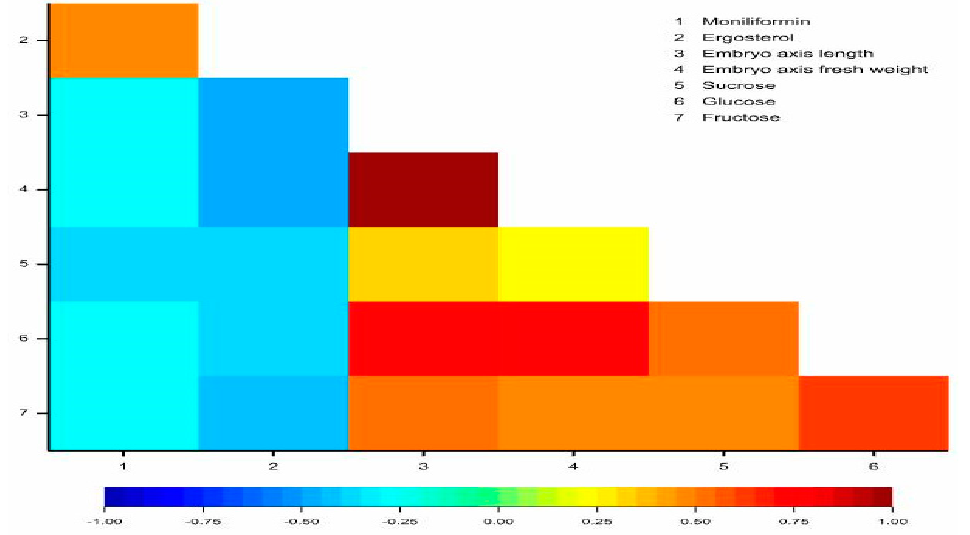
Figure 6. Heatmap matrix for linear Pearson’s correlation coefficients between moniliformin, ergosterol, embryo axis length, embryo axis fresh weight, sucrose, glucose, and fructose (r cr = 0.2686).